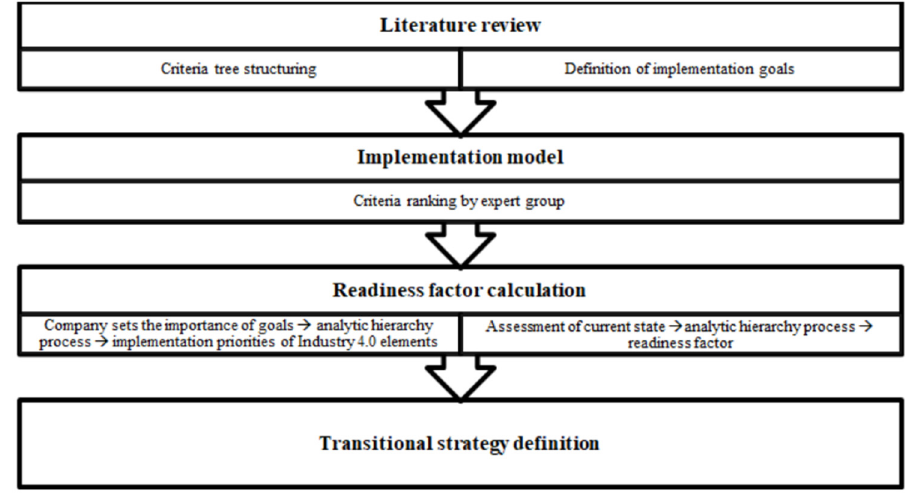
Figure 1. Framework of the innovative, decision support-based readiness factor calculation model.